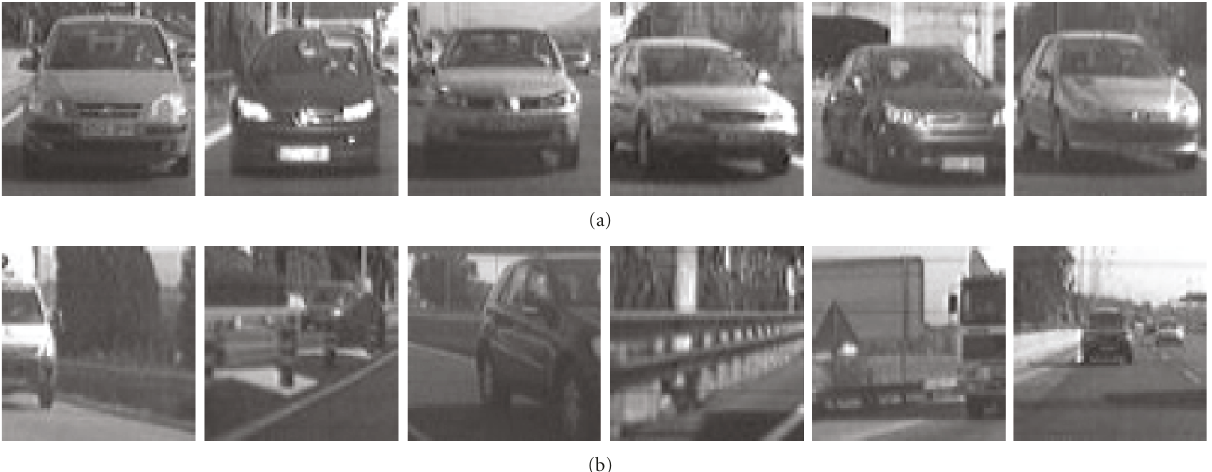
Figure 13: Rear data set. (a) positive samples (vehicles). (b) negative samples.